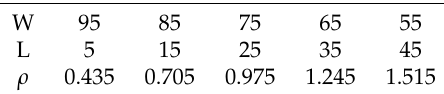
Table 2. W and L denote the numbers of sensors with ρ i = 0.3 and ρ i = 3.0, respectively. ρ denotes the resultant